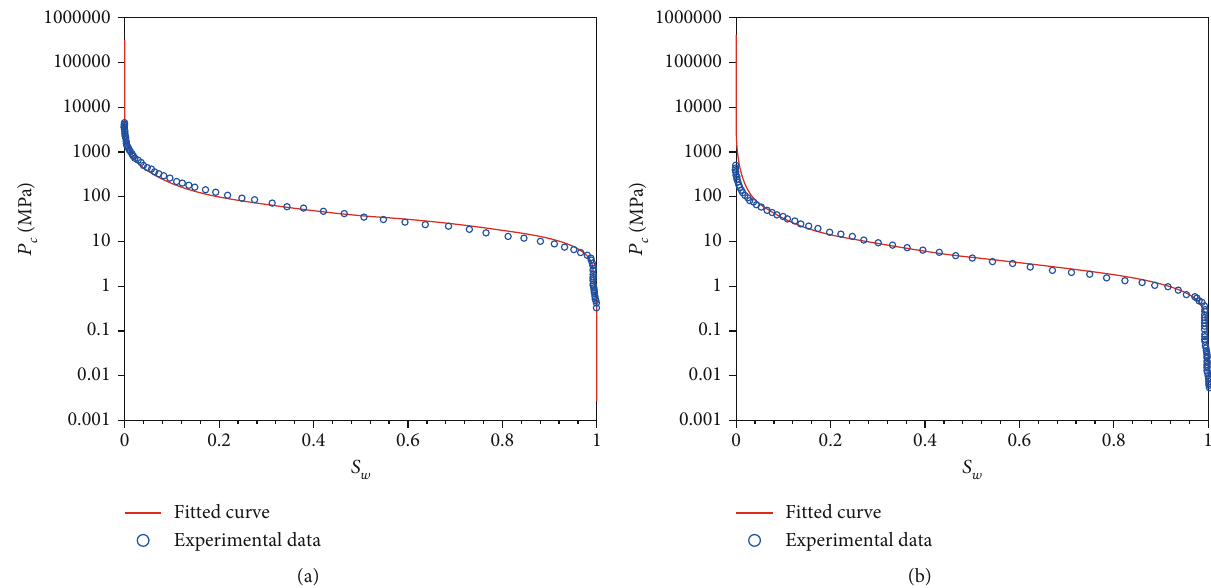
Figure 3: Fitting the capillary curve by Van Genutchen model ((a) is for sample A and (b) is for sample B). Table 2: Parameters calculated by NMR measurement.